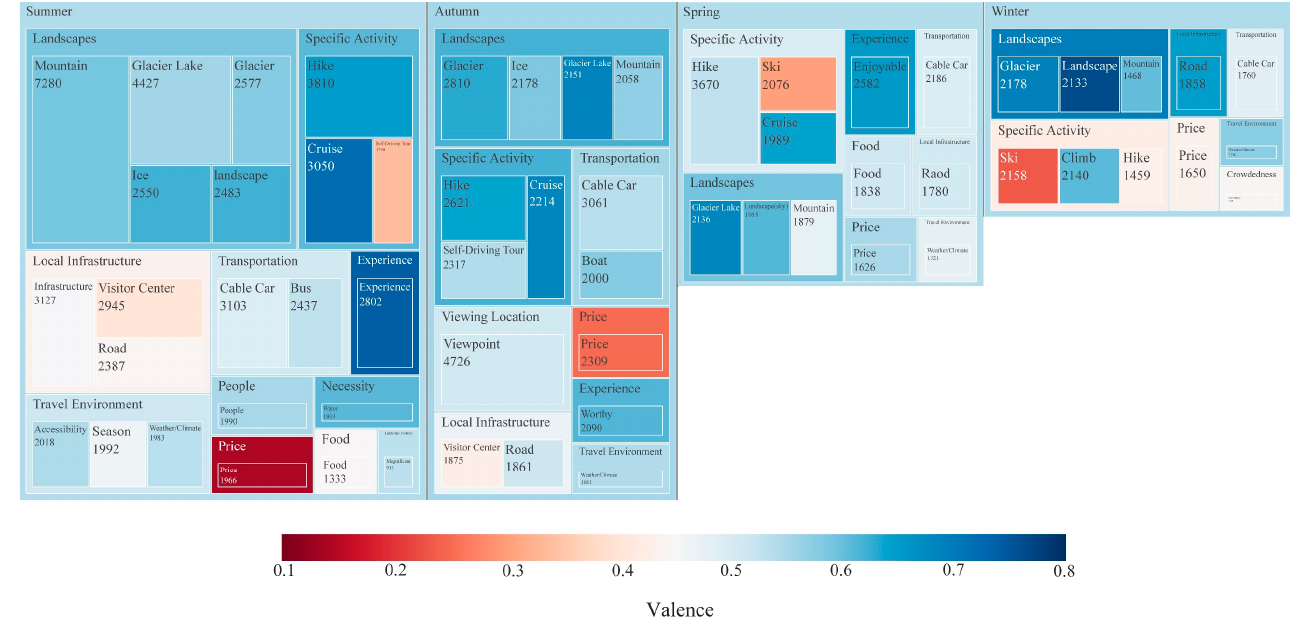
Figure 6. Seasonal differences in the image of glacier tourism destinations.